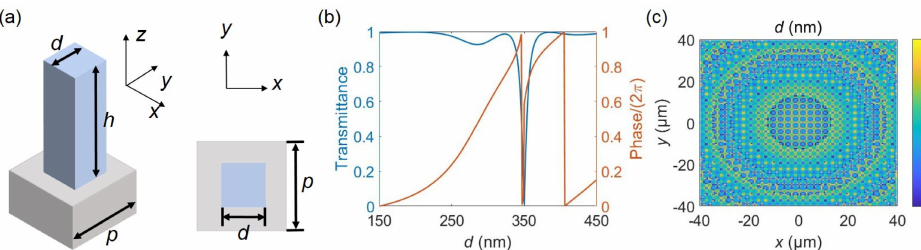
Figure 3. Design of the unit cell. ( a ) Schematic of the unit cell. ( b ) Simulated transmittance (blue line) and normalized phase (red line) of the unit cell. The width d varies from 100 nm to 450 nm. ( c ) Width profile of the designed